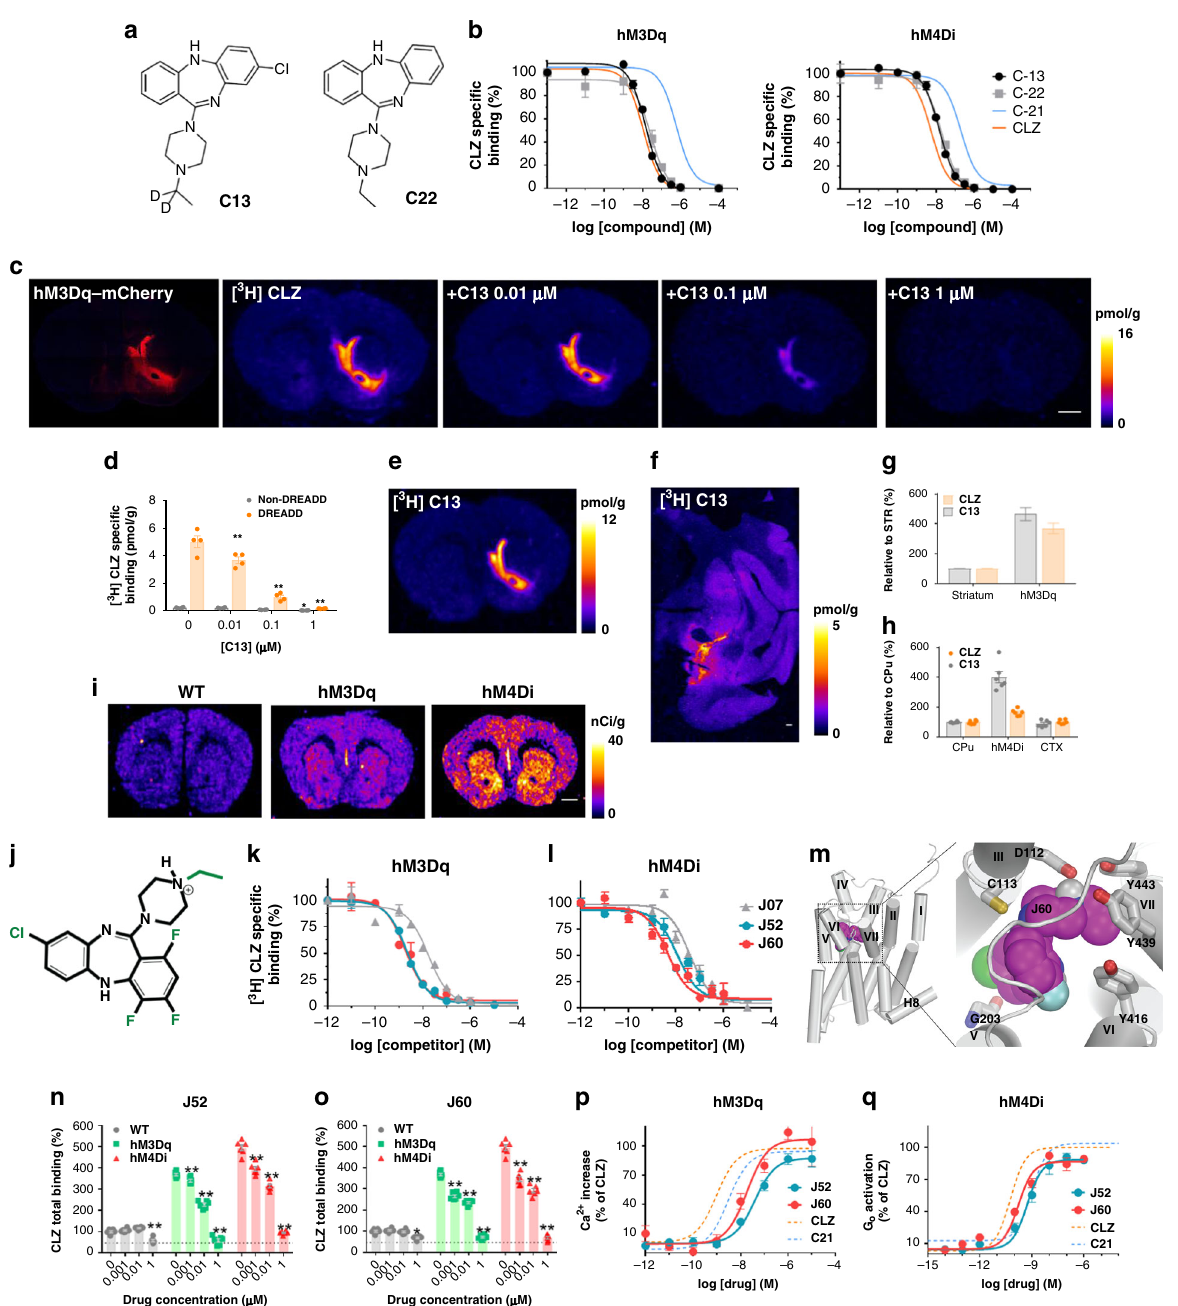
Fig. 1 New DREADD ligands displaying high in vitro DREADD af fi nity and potency. a Compound 13 (C13) and Compound 22 (C22) structures. b Binding competition curves of [ 3 H]CLZ versus increasing concentrations of C13 and C22 in HEK-293 cells expressing DREADDs. C13 and C22 exhibit comparable DREADD af fi nity to clozapine (CLZ) with C13 showing ~twofold greater af fi nity than C22. CLZ and C21 competition curves from Supplementary Fig. 1 are overlaid for comparison. c , d C13 selectively blocks [ 3 H]CLZ binding to DREADDs in mouse slices at 10 nM. Representative images of sections collected from 3 different mice are displayed and quanti fi ed in ( d ) as mean ± SEM. Two-way ANOVA followed by Dunnett ’ s test, * p < 0.05 and ** p < 0.01 compared with the respective vehicle. e – h [ 3 H]C13 binds with greater selectivity than [ 3 H]CLZ to DREADDs in mouse and monkey brain tissue expressing AAV- hM3Dq and AAV-hM4Di, respectively. i Intraperitoneal (IP) injection of [ 3 H]C13 readily enters the brain and accumulates in DREADDs expression areas in D1-DREADD mice. Representative images from 3 mice per condition. j – l JHU37107 (J07), JHU37152 (J52), and JHU37160 (J60) are high-af fi nity DREADD ligands. m Docking and molecular dynamics simulation of J60 in the ligand binding pocket of a hM4Di model. n , o J60 and J52 selectively displace [ 3 H]CLZ at a concentration of 1 and 10 nM from hM3Dq and hM4Di expressed in mouse brain sections ( n = 3 mice per condition). p , q J60 and J52 activate hM3Dq and hM4Di expressed in HEK293 cells with high potency (experiments performed 3 – 5 times). In all cases, data are represented as mean ± SEM. Scale bars are 1 mm. Source data are provided as a Source Data fi